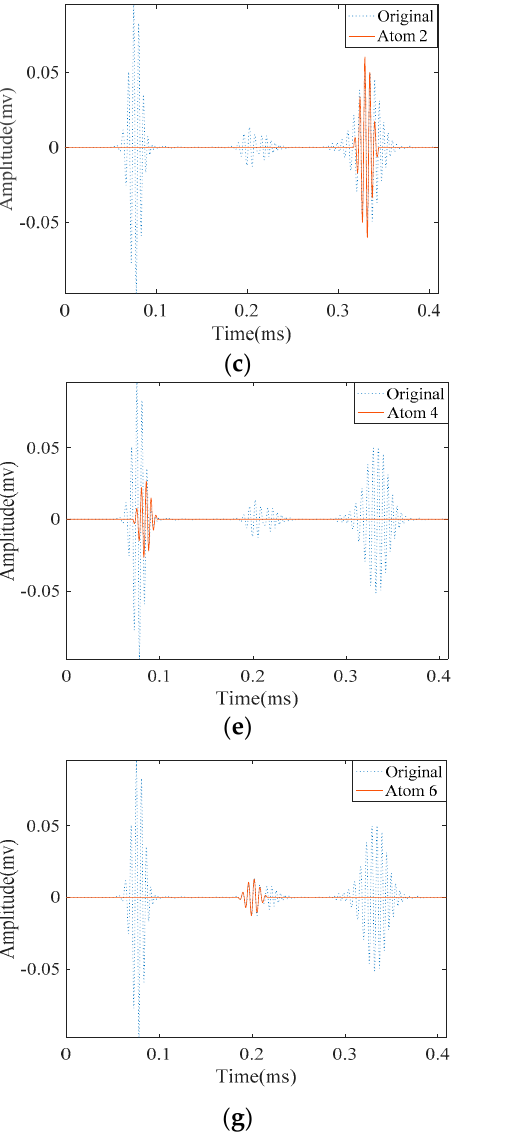
Figure 12. Results obtained by applying MP to the simulation signal in a pipe with the 27 mm length notch: ( a ) the original signal; ( b ) approximated atom 1—the direct signal; ( c ) approximated atom 2—the reflection from the pipe end; ( d ) approximated atom 3—the reflection from the pipe end; ( e ) approximated atom 4—the direct signal; ( f ) approximated atom 5—the reflection from the pipe end; ( g ) approximated atom 6—the reflection from the first edge of notch; and ( h ) approximated atom 10—the reflection from the second edge of notch.